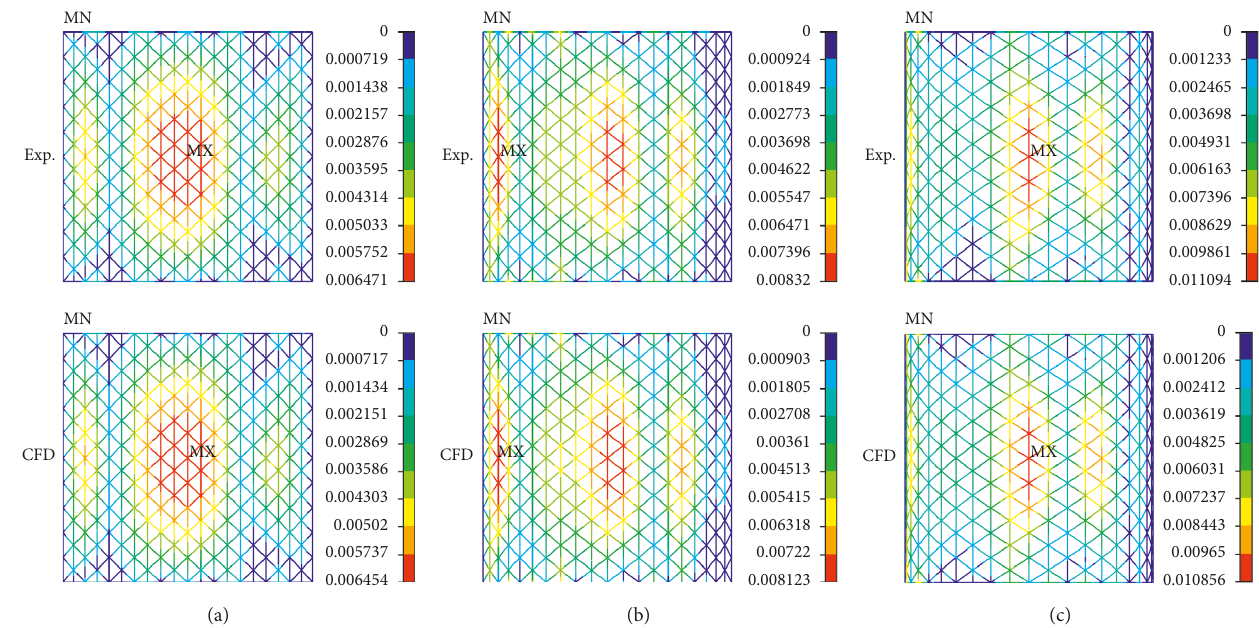
Figure 9: Comparison of the response displacements of cylindrical shells against wind loads obtained from numerical and experimental results. (a) R / S � 1/6. (b) R / S � 1/3. (c) R / S � 1/2.